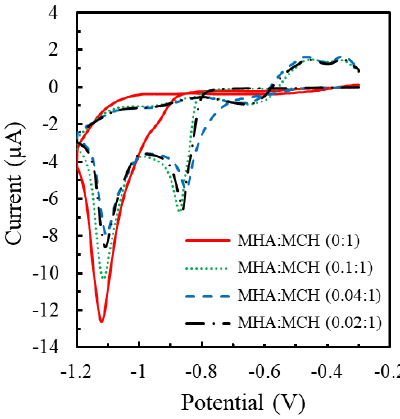
Figure 1. Cyclic voltammograms respectively obtained from the MHA / MCH-modified electrodes with the concentration (mM) ratios of 0:1 (red solid line), 0.1:1 (green dotted line), 0.04:1 (blue dashed line) and 0.02:1 (black dot-dashed line) in 0.5 mM NaOH from − 0.3 V to − 1.2 V with the scan rate of 100 mV / s.